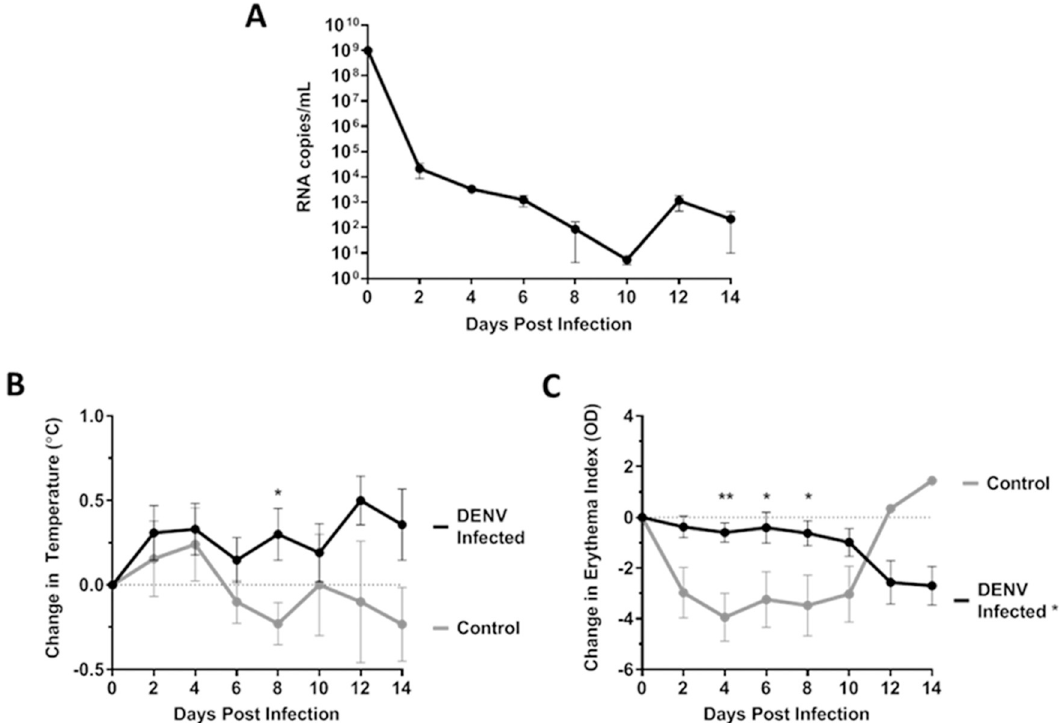
Fig 5. Hu-NSG mice have viremia and clinical signs of disease after DENV infection. (A-C) Hu-NSG mice were infected subcutaneously with 10 6 PFU DENV/mouse. Viremia (n = 17 DENV infected) (A), temperature change (n = 25 DENV infected, n = 10 control) (B), and erythema change (n = 25 DENV infected, n = 10 control) (C) were measured throughout the infection. Data are represented as the mean number of RNA copies per milliliter of serum (A), mean change in temperature (˚C) from baseline (B), or mean change in erythema index (O.D.) from baseline (C). Error bars are 1 SEM. (B-C) Statistical significance was determined using a two-way ANOVA and multiple comparisons t-test (with Holm-Sidak correction). Statistical significance next to the virus strain name indicate that that infection was significantly different from the UV-inactivated control as assessed by two-way ANOVA. Significance at a specific timepoint indicates that the condition at that timepoint was significantly different from the UV-inactivated control via t-test but that the overall infection was not significantly different via ANOVA. � p < 0.05; �� p < 0.01; ��� p < 0.005; ���� p <